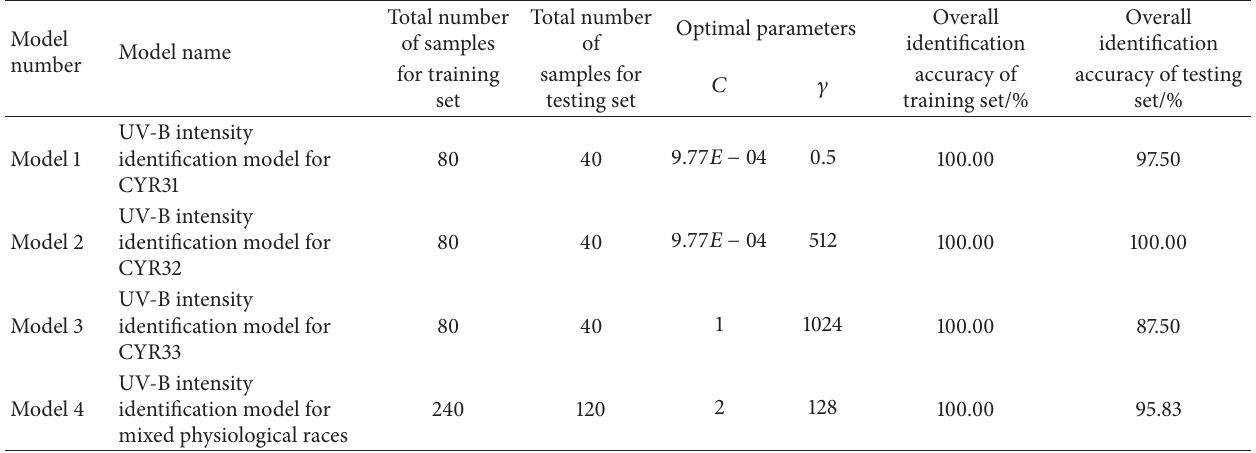
Table 1: The best indexes for UV-B intensity identification SVM